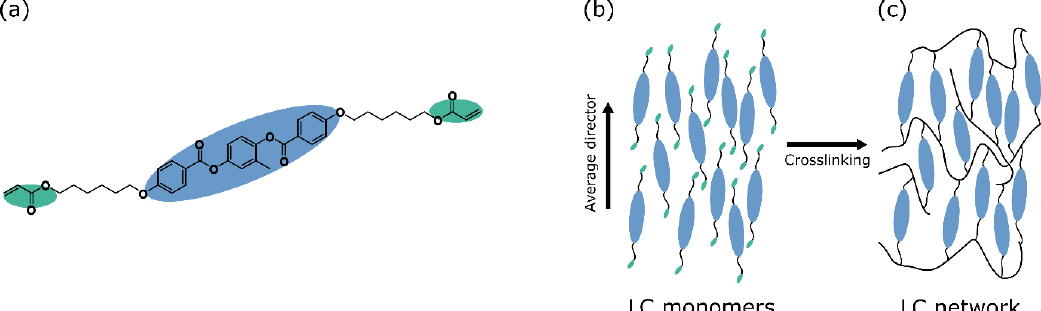
Figure 1. Preparation of LC polymers. ( a ) Typical molecular structure of a liquid crystal monomer, with the stiff core indicated in blue and the reactive end-groups, in this case acrylates, indicated in green. ( b ) A nematic mesophase of LC monomers with uniaxial order. The LC reactive end groups can be directly and densely crosslinked into an LC network ( c ), where the LC order is frozen in so that the mesophase is retained also when the material temperature is brought outside of the liquid crystal temperature